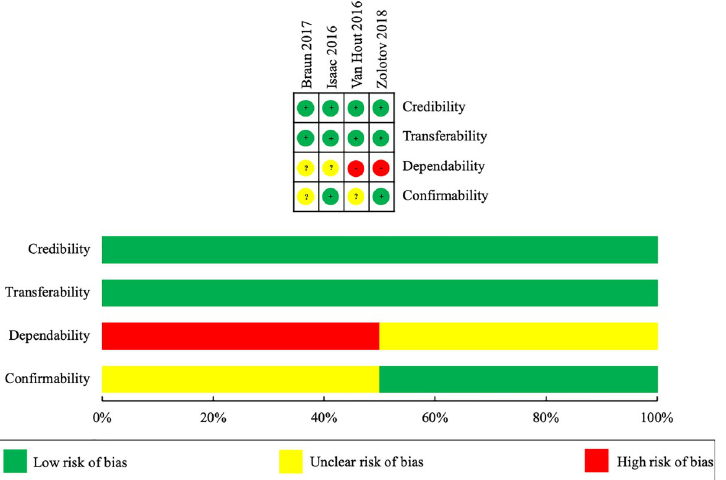
Fig 3. Risk of bias summary and graph–qualitative